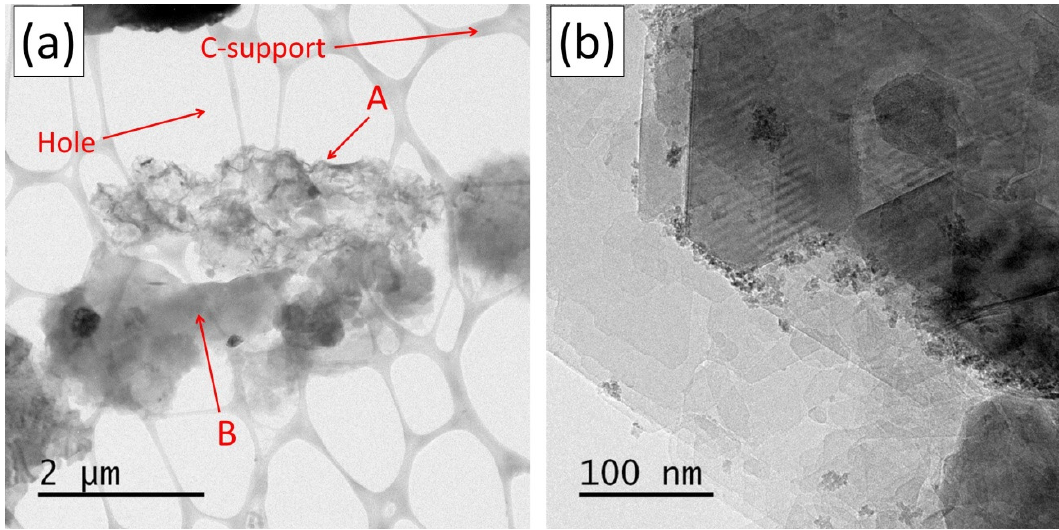
Figure 2. TEM images of the sub-2 µm total clay fraction of the contaminant solids. ( a ) Low magnification image showing two types of clay aggregates (A and B, see text), ( b ) Higher magnification image showing face-to-face stacking of clay mineral platelets and the presence of metal oxide nanoparticles dispersed on the clay mineral surfaces.